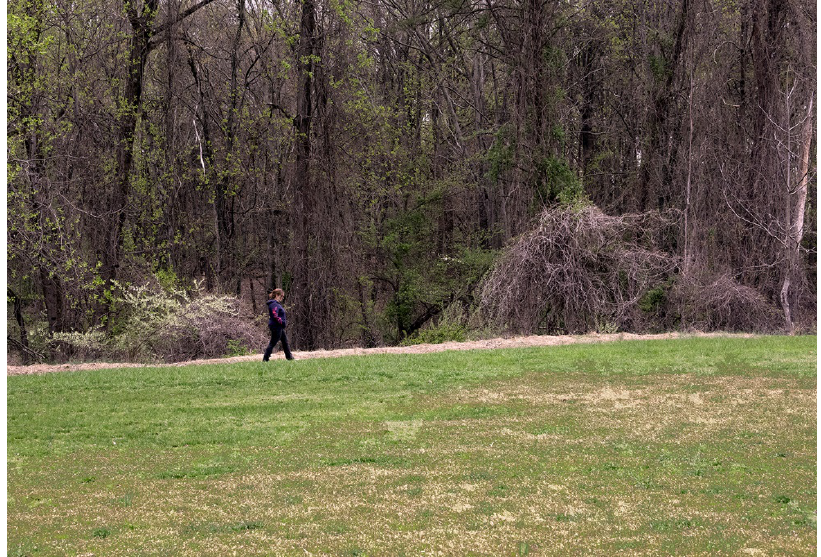
Courtesy of the